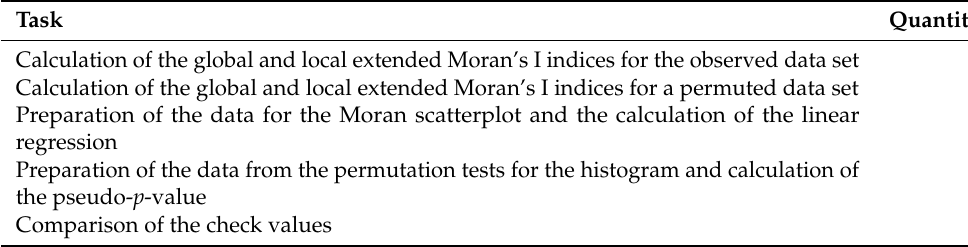
Table 2. Chosen tasks for task